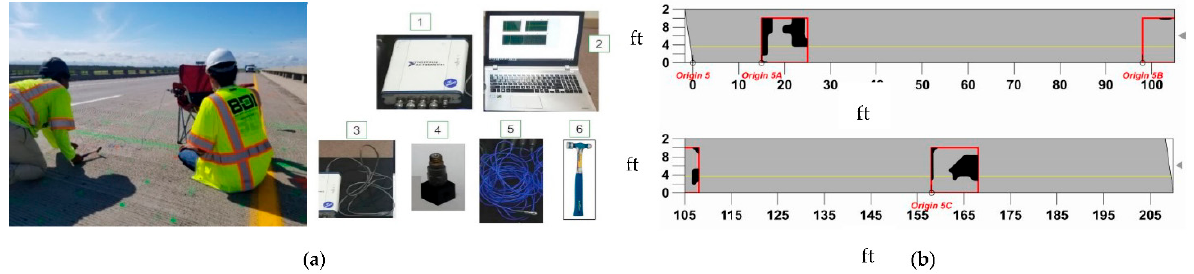
Figure 3. IE data collection depicting ( a ) crew and set up for collecting data ( b ) IE data collection layout for FR SB.